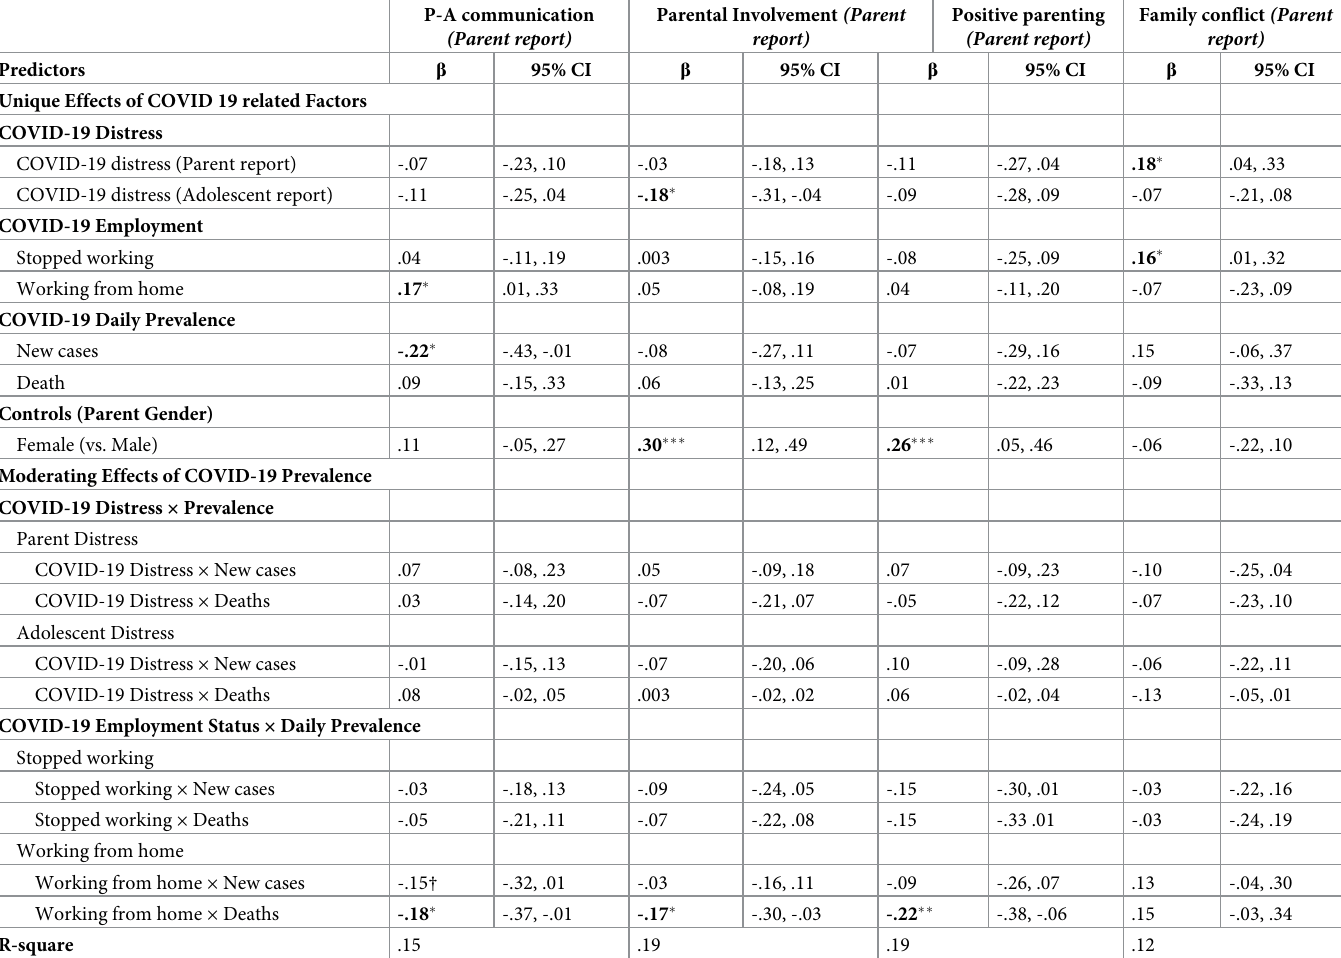
Table 2. Unique and moderating effects of COVID-19 related factors on parent’s perception of family functioning.